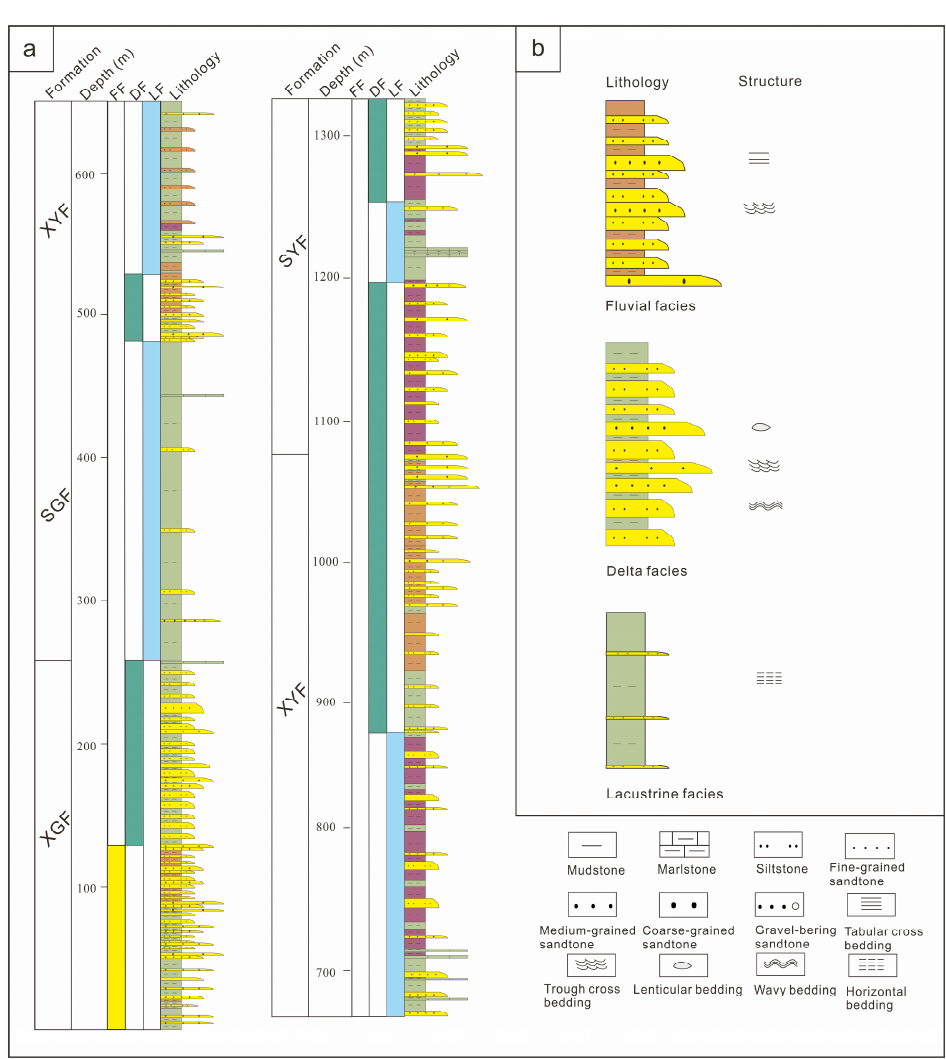
Figure 3. ( a ) Sedimentary facies evolution of Dongchashan outcrop; ( b ) the associations of the lithofacies representing different sedimentary facies. XGF: Xia Ganchaigou Formation; SGF: Shang Ganchaigou Formation; XYF: Xia Youshashan Formation; SYF: Shang Youshashan Formation.